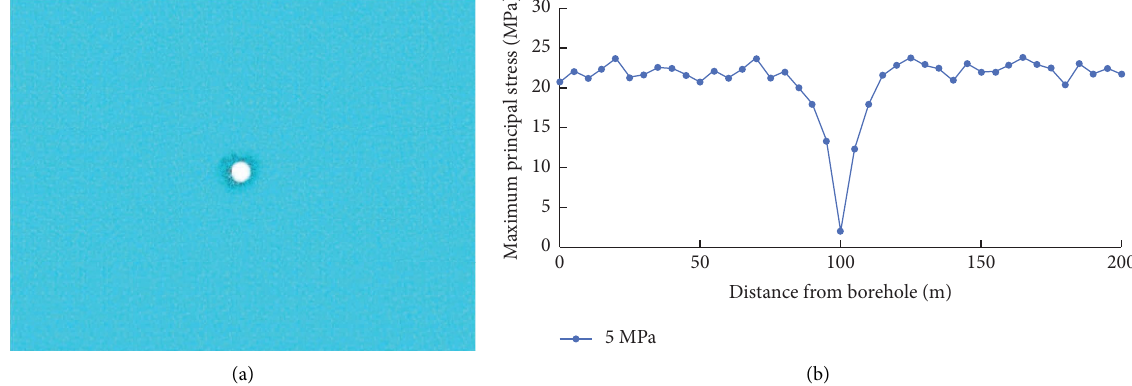
Figure 6: Fracture and stress distribution of borehole after slit. (a) Distribution of fractures. (b) Stress distribution